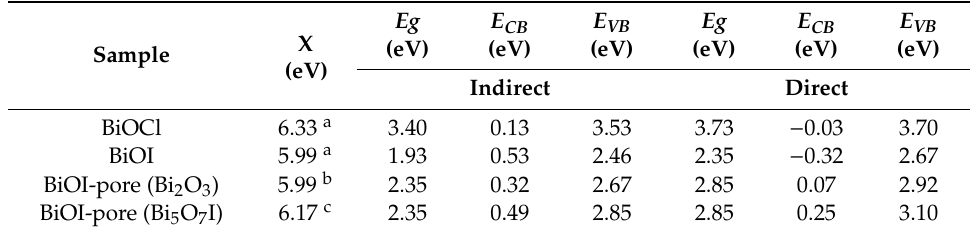
Figure 11. Schematic diagram of the band structure of TiO 2 , BiOCl, BiOI, and phase transformation of BiOI into alkaline pH aqueous solution (Bi 2 O 3 and Bi 5 O 7 I). Table 4. Absolute electronegativity ( χ ), estimated band gap ( Eg ) from DRS measurements and calculated E CV and E VB of BiOX